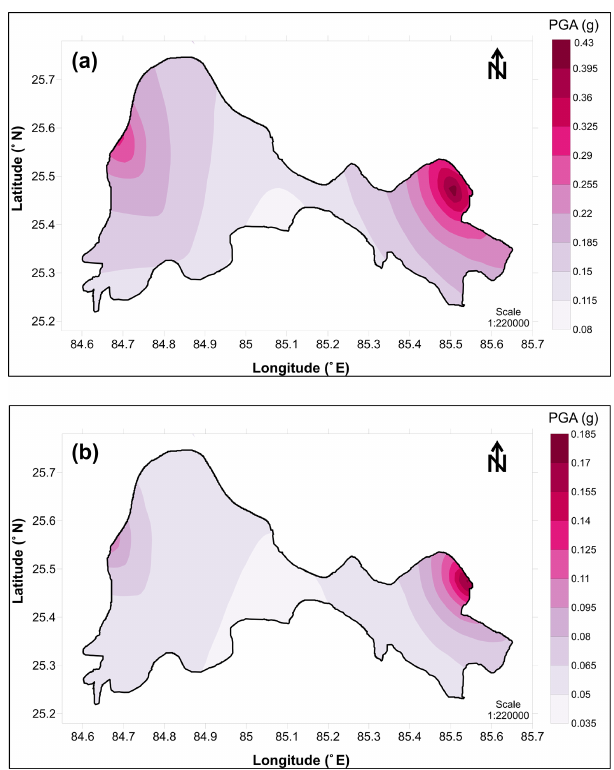
Figure 9. (a) PSHA map for Patna urban centre for 2% probability of exceedance in 50 years using the areal seismic zone. (b) PSHA map for Patna urban centre for 10% probability of exceedance in 50 years using the areal seismic